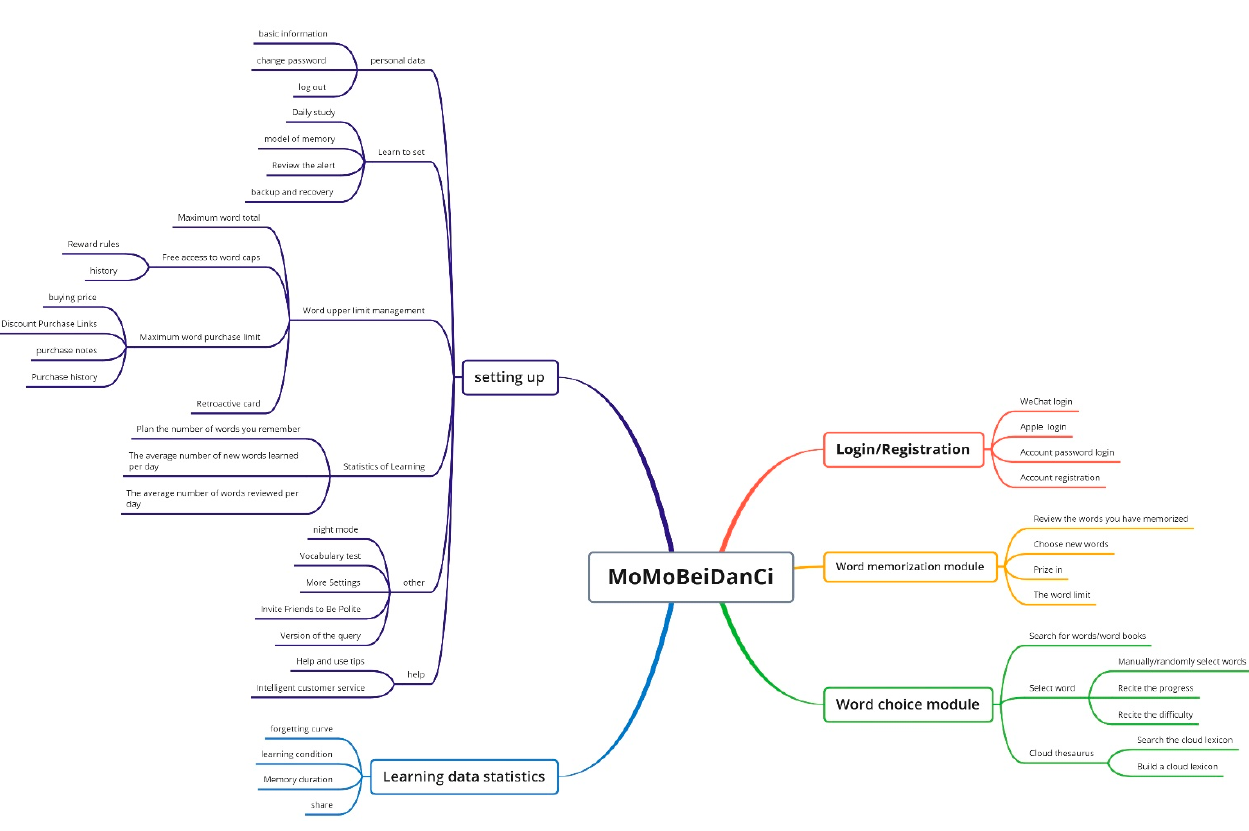
Figure 2. Distribution of MoMoBeiDanCi APP modules.